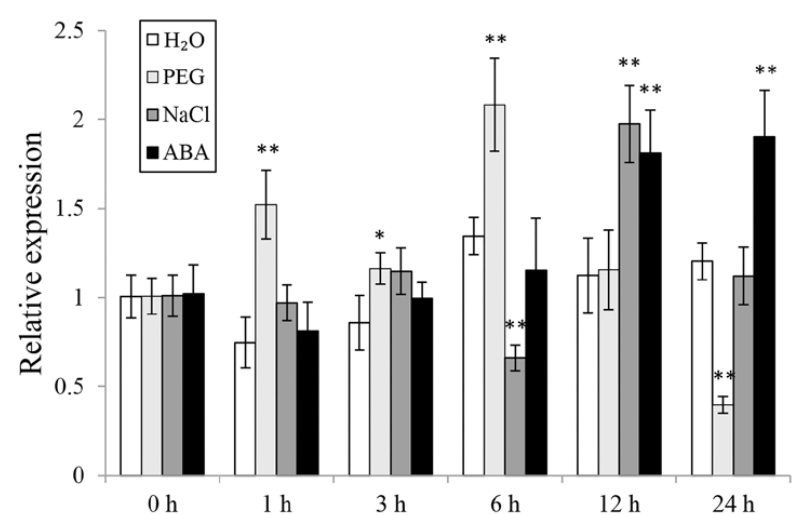
Figure 3. Expression level analysis of IbWRKY2 in Xushu55-2 before and after H 2 O, 30% PEG6000, 200 mM NaCl, and 100 µM ABA treatments. Data are presented as means ± SE (n = 3). The time points 0, 1, 3, 6, 12, and 24 h indicate the time after the related treatment; * and ** indicate a significant difference at p < 0.05 and p < 0.01 compared with the related H 2 O control, respectively.